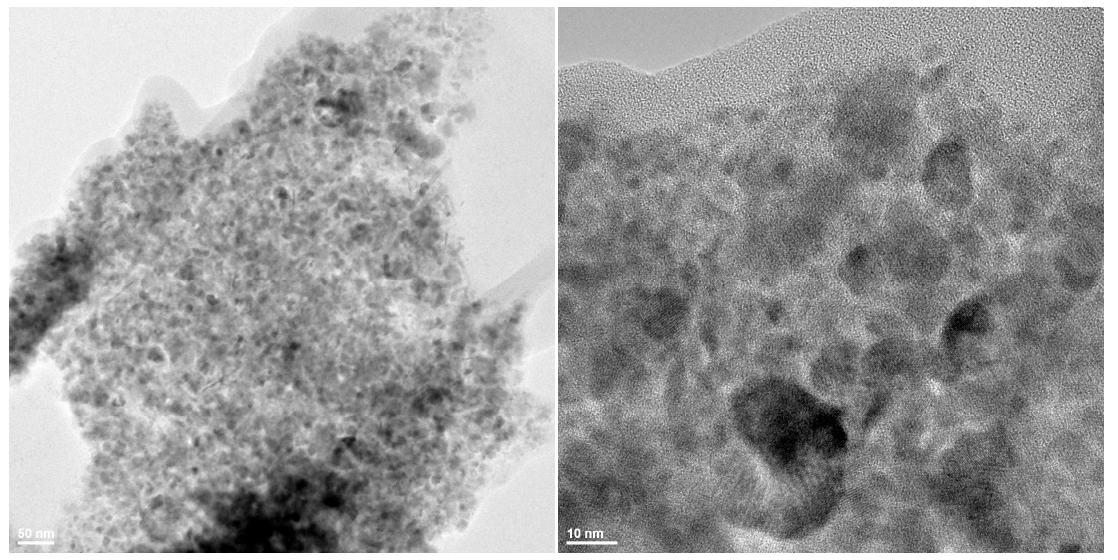
Figure 1. TEM images of Fe 3 O 4 @C 14 nanostructures.